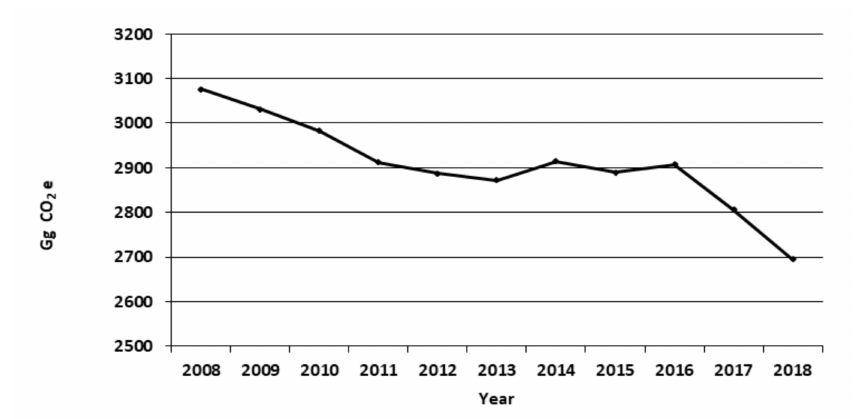
Figure 1. Evolution of total greenhouse gas emissions (CH 4 and N 2 O) from the total Tunisian livestock (Gg CO 2 e) throughout the studied period (2008–2018).